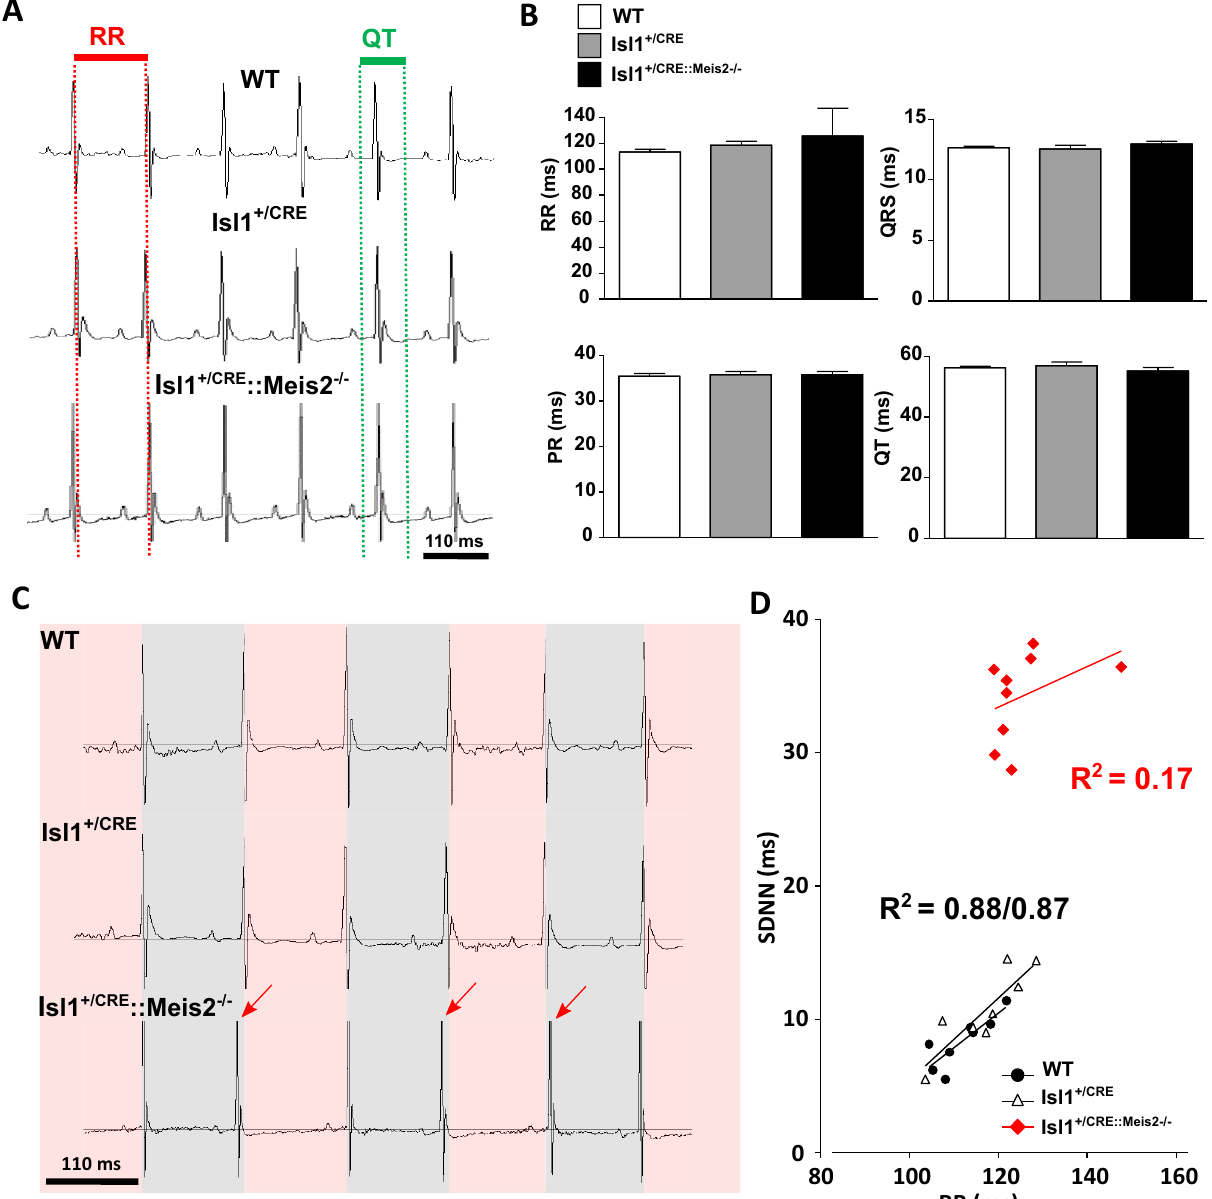
Figure 2. Increased sinus rhythm variability in Isl1 +/CRE ::Meis2 LoxP/LoxP mice. Telemetric recording of ECG in vigil WT, Isl1 +/CRE and Isl1 +/CRE ::Meis2 LoxP/LoxP mice in basal conditions. ( A ) Typical ECG traces for WT, Isl1 +/CRE and Isl1 +/CRE ::Meis2 LoxP/LoxP ( B ) Graphs showing the RR, PR, QRS and QT durations in the three groups of mice. No difference was observed between genotypes. n = 11–12 mice in each group. ( C ) Typical ECG traces of sinus variability monitored in WT, Isl1 +/CRE and Isl1 +/CRE ::Meis2 LoxP/LoxP mice. ( D ) Graph showing the correlation between SDNN and RR in the 3 groups of mice. n = 7–9 mice in each group. SDNN = Standard Deviation of normal to normal beat